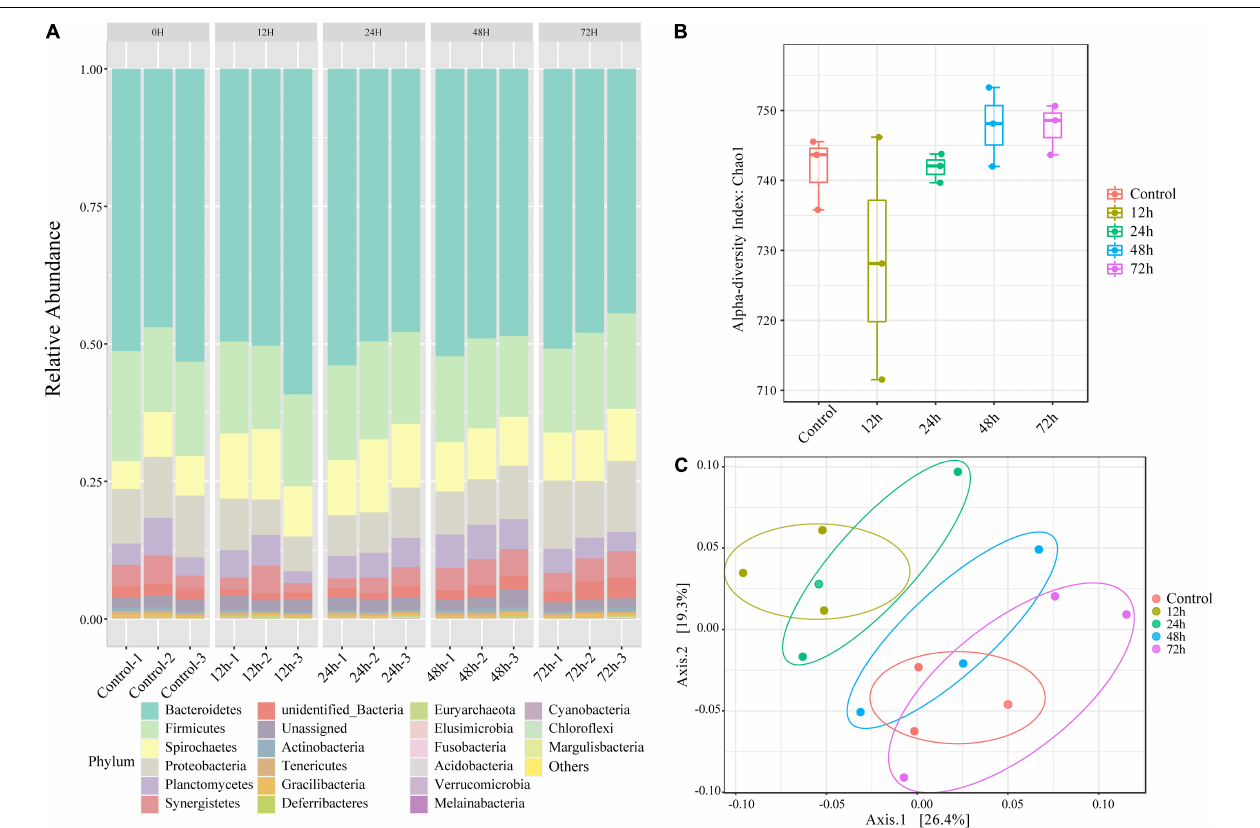
FIGURE 2 | Changes in the composition of O. formosanus gut microbiome following M. robertsii infection based on 16S rRNA sequencing data. (A) Relative abundances of gut microbes at the phylum level. There are five clusters, each including three independent repetitions. Each bar graph demonstrates the microbial community composition of one independent repetition in the corresponding group. (B) Alpha-diversity comparison based on the Chao1 diversity index. (C) Principal coordinate analysis of gut microbial community composition was based on unweighted UniFrac distance. Three replications of the same treatment group were represented by dots of the same color. There were four treatment groups and one control